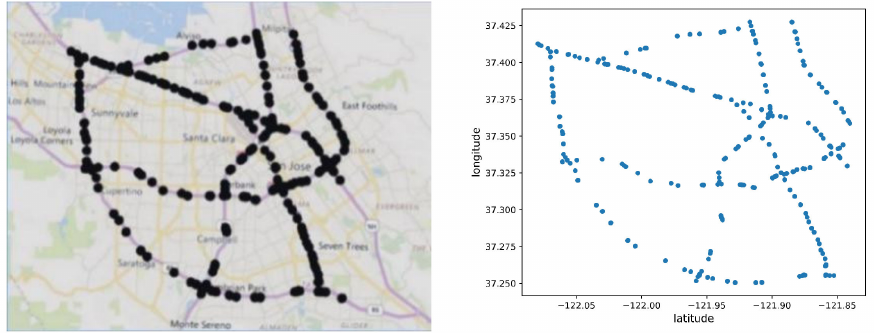
Figure 7. PeMS_BAY data set for traffic prediction. Black points mean location of sensors, each sensor measures traffic data every 30 s. PeMS_BAY constructed a road network based on the measured